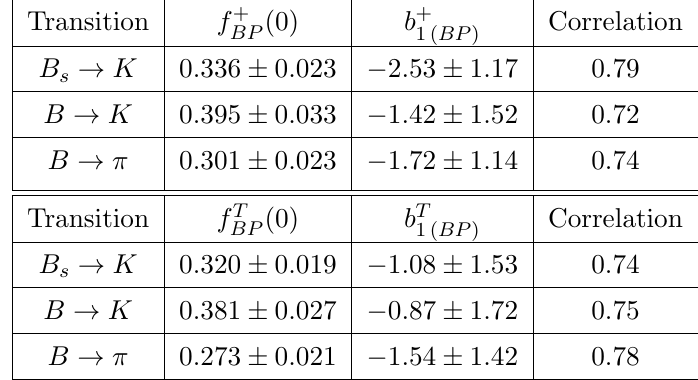
Table 2 . The (cid:12)tted parameters of the z -expansion (3.1) for the vector (upper panel) and tensor (lower panel) B ! P form factors at 0 < q 2 < 12 : 0 GeV 2 calculated from LCSRs. twist-3 and twist-4 DAs, not shown in table 1 for brevity, are taken from [21], they